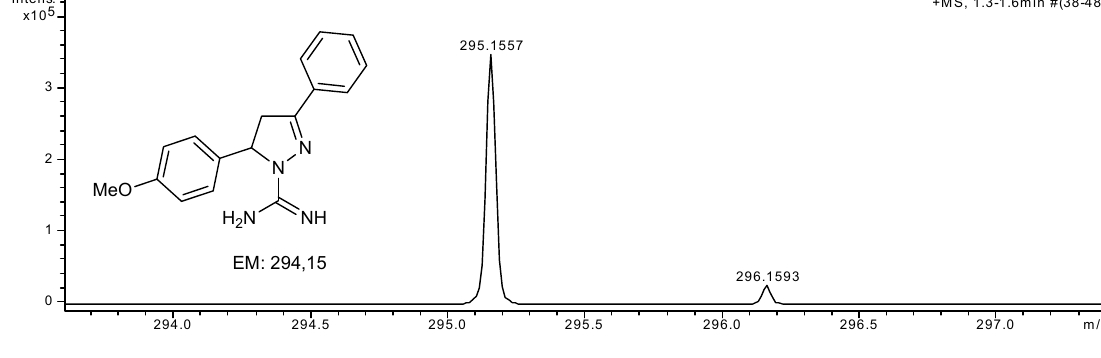
Table 1. Experimental High Resolution Mass Spectrometry data for compounds 1 – 11 . Pyrazole a Molecular Formula Calculated